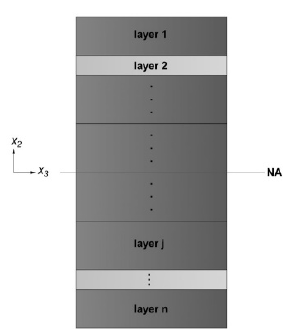
Figure 1. Cross-section of a laminated Euler-Bernoulli beam